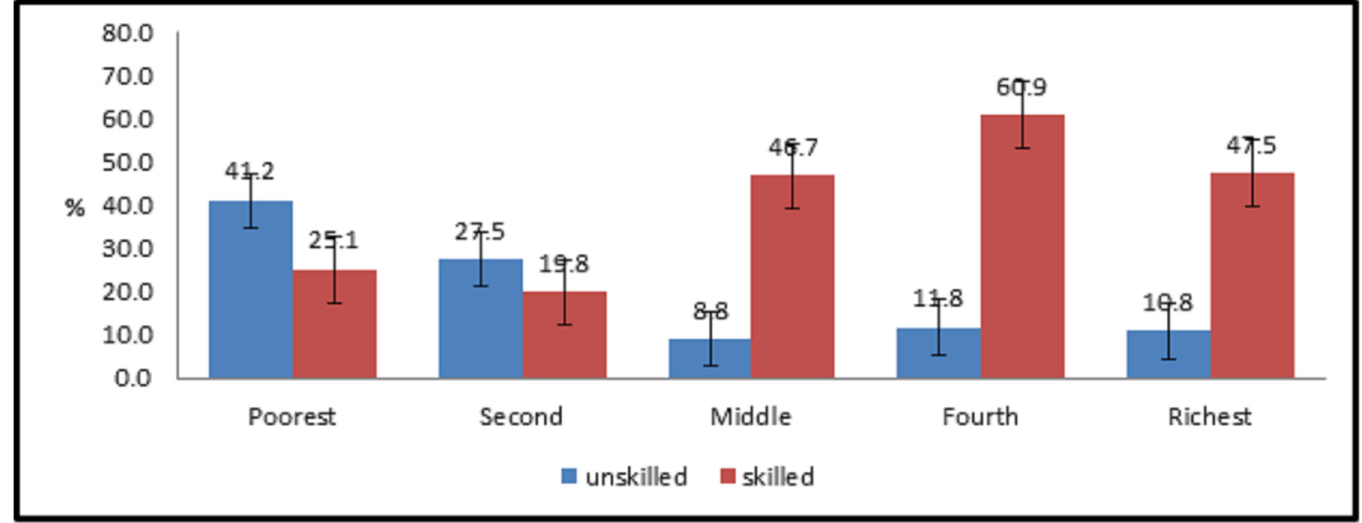
Fig 2. Skill level and